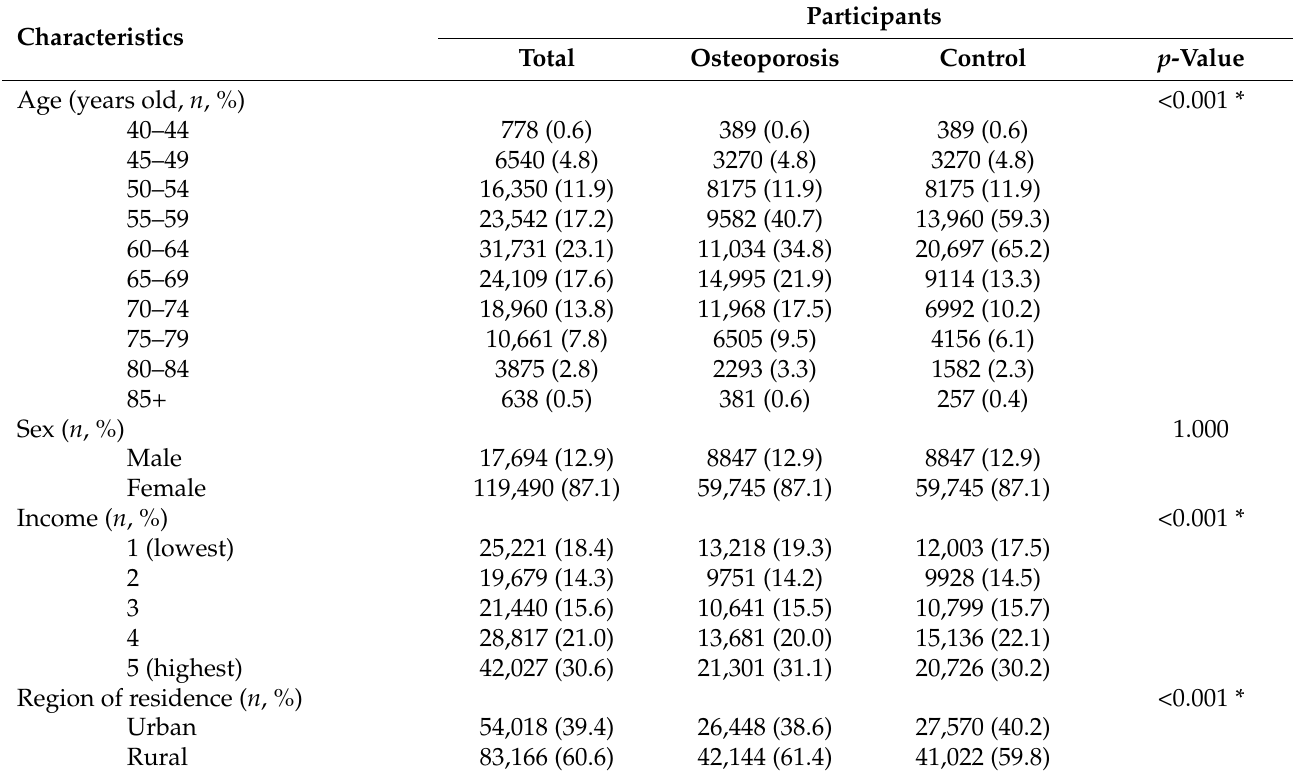
Table 1. General characteristics of the